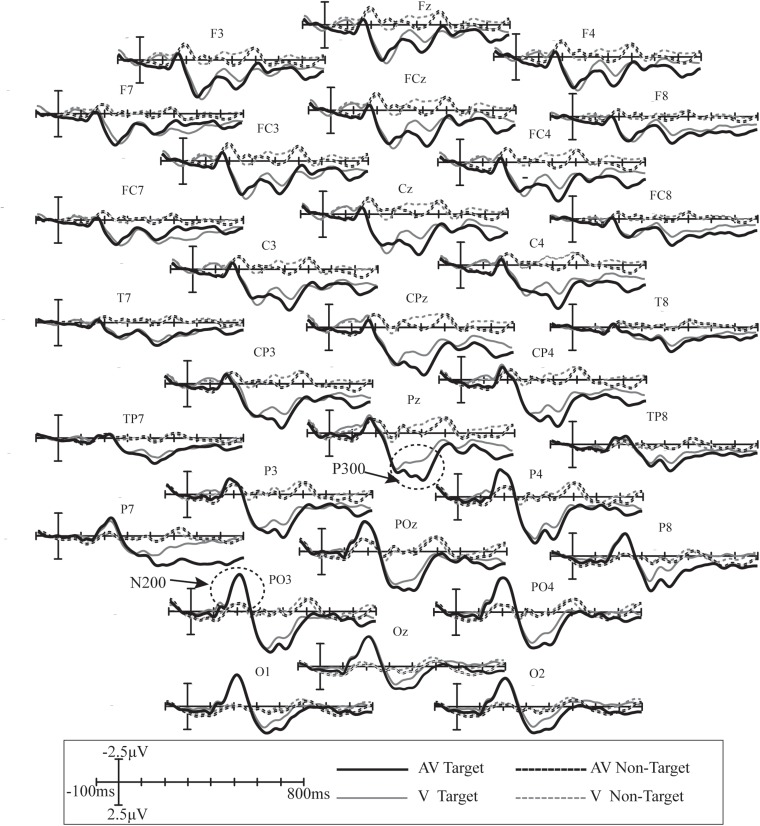
Superimposed grand-averaged ERPs elicited by target and non-target stimuli at 31 electrodes in the V and AV spelling paradigms. AV target, the ERP waveform elicited by the audiovisual target stimuli; AV non-target, the ERP waveform elicited by the audiovisual non-target stimuli; V target, the ERP waveform elicited by the visual target stimuli; V non-target, the ERP waveform elicited by the visual non-target stimuli.